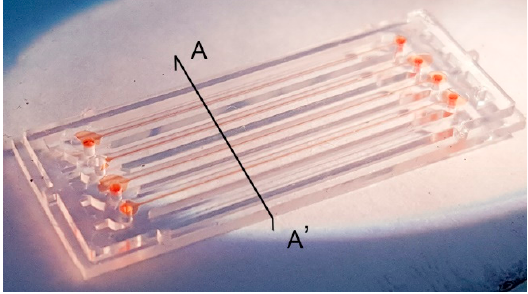
Figure 3. Leakage test of (PMMA)–PC microchip with red food dye.